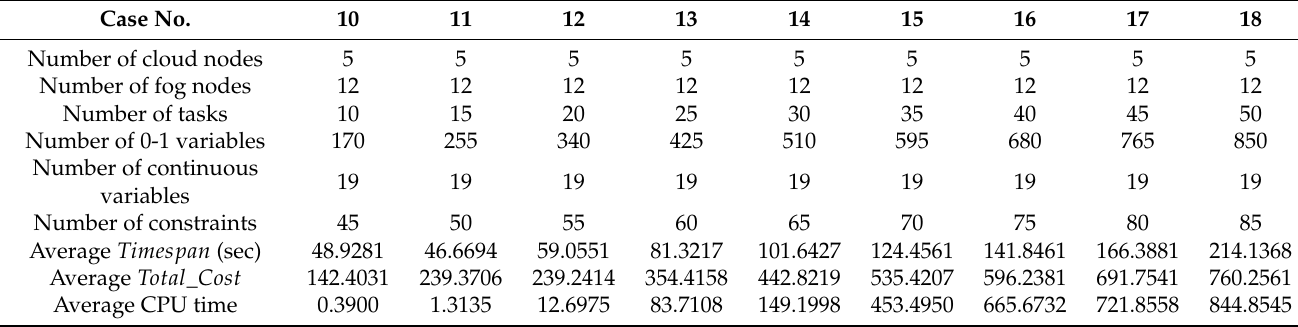
Table 4. Experimental results of the proposed method for 5 cloud nodes and 12 fog nodes (dataset 2). Case No.